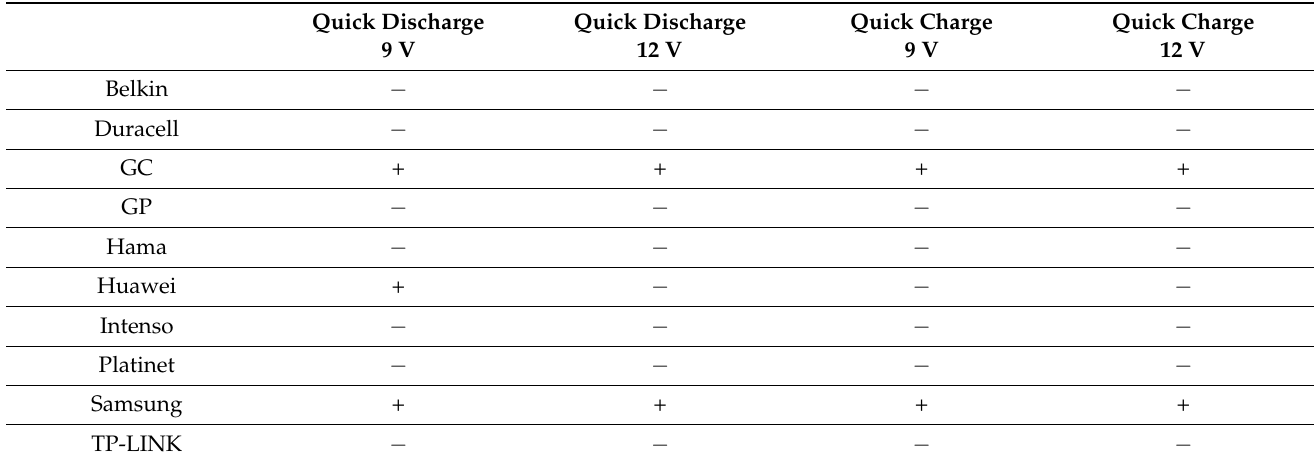
Table 4. Comparison of the number of possible discharging and charging modes of power banks (‘6.’ only standard mode at 5 V, ‘+’ possible quick modes at 9 V or 12 V).